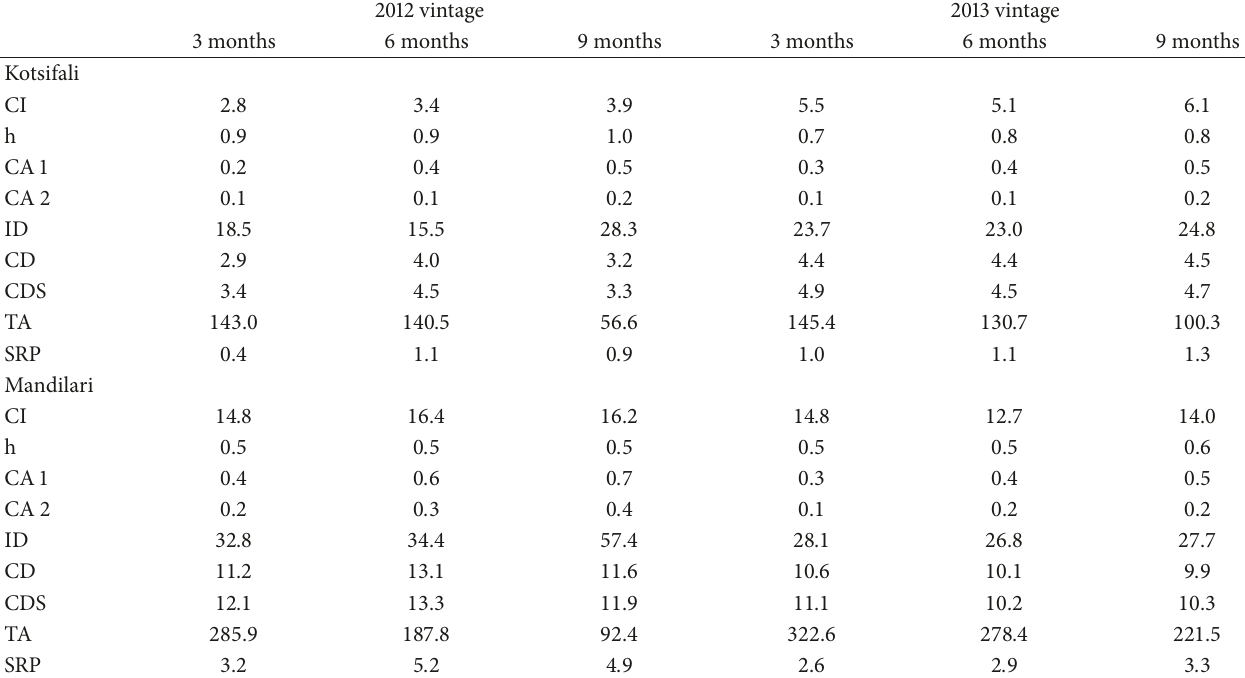
Table 2: Changes in average values of color parameters and chemical age indexes (CI: color intensity, h: hue, CA1: chemical age i, CA2: chemical age ii, ID: degree of ionisation of anthocyanins, CD: color density, CDS: color density corrected for SO 2 , TA: total anthocyanin concentration, SRP: SO 2 resistant pigments) during maturation, for Kotsifali and Mandilari